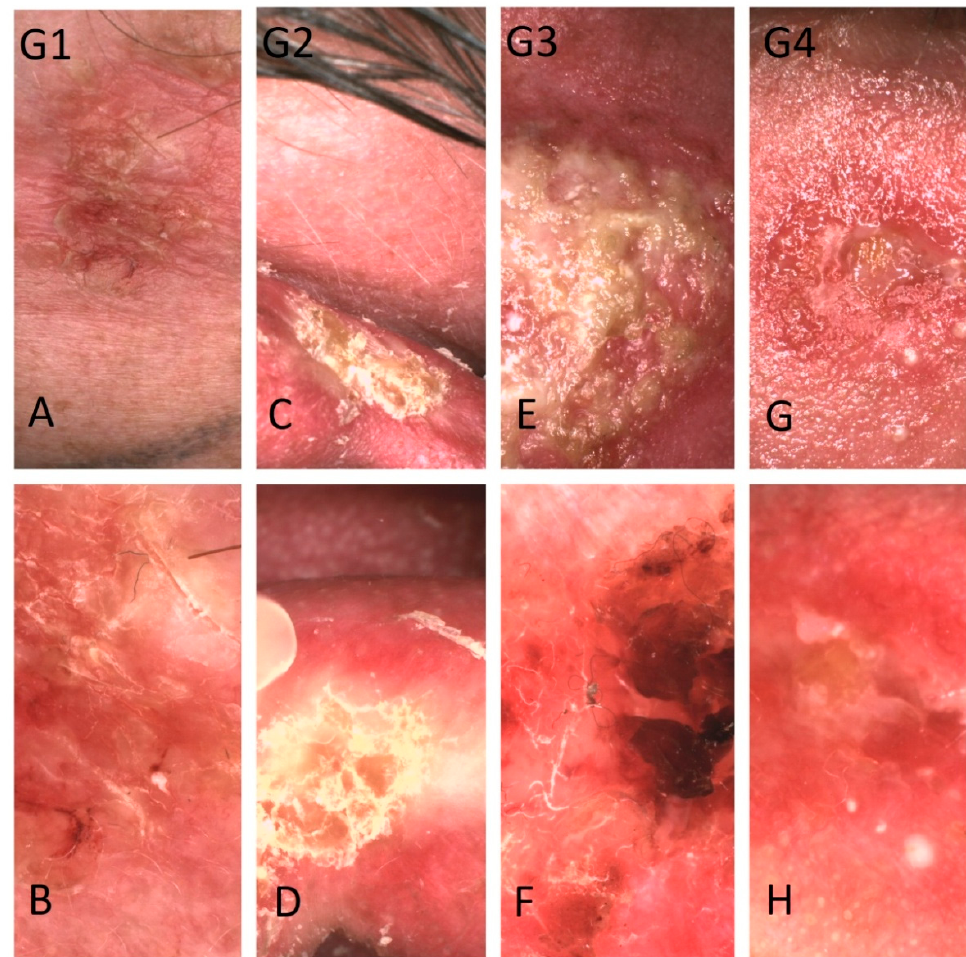
Figure 8. Dermoscopic images of various basal cell carcinomas with coexisting acute radiodermatitis in stage from G1 to G4 were clinically assessed according to RTOG criteria [21] ( A )—minor erythema of the surrounding area with moderate dry desquamation (G1), ( B )—dermoscopic image (G1) acute radiodermatitis reveals yellow scale with linear vessels in non-specific distribution in the surrounding area, ( C )—bright erythema of the tumour’s surroundings with dry desquamation (G2), ( D )—dermoscopic image of acute radiodermatitis (G2) shows yellow scale ( E )—confluent, moist desquamation (G3), ( F )—dermoscopic image (G3) with linear vessels in unspecific distribution, yellow and brown crust. ( G )—ulceration in acute radiodermatitis (G4), ( H )—dermoscopic image (G4) reveals the absence of any dermoscopic features.